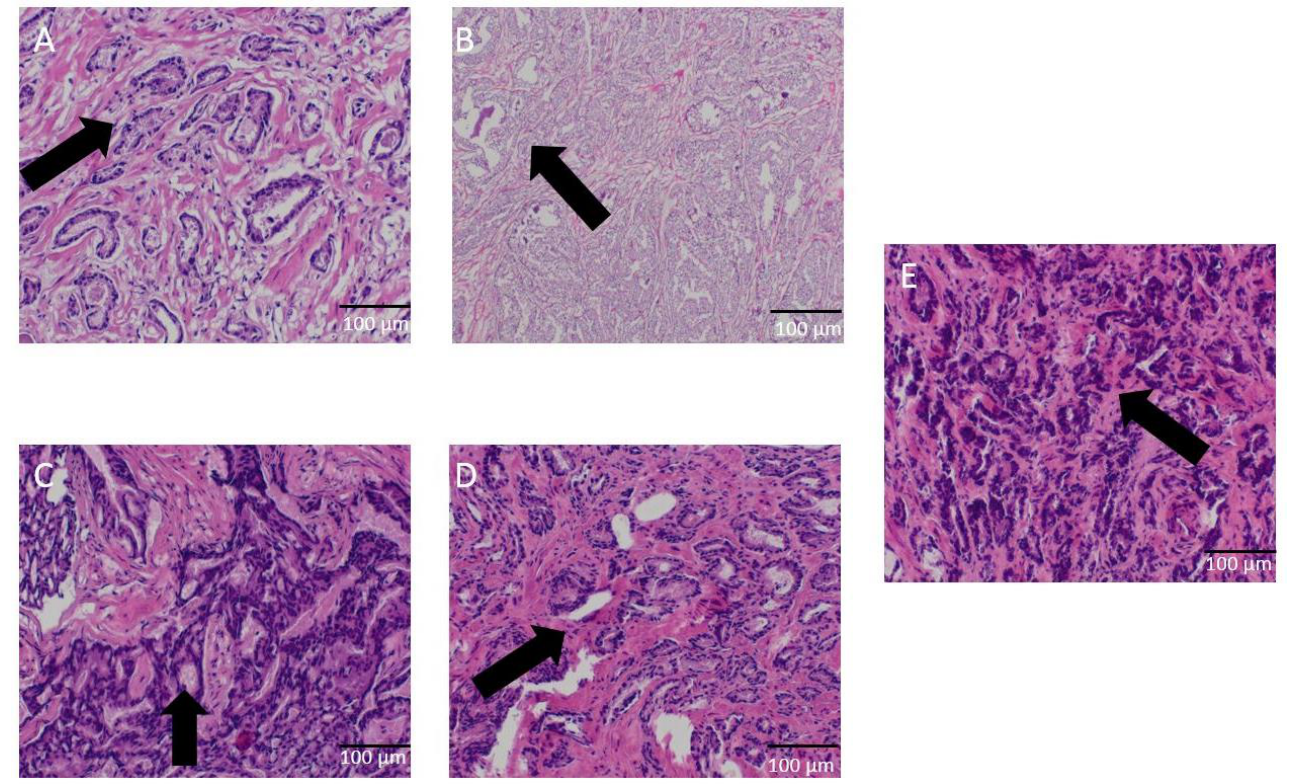
Figure 4. Prostate cancer tissue after PDT with different concentration of RB. Arrows indicate the observed changes presented in the description. Upon application of 0.01 mM RB ( A ), discrete chromatin condensation in most of the cancer cell nuclei and swelling of the stroma are visible. Predominantly normal prostate cancer cells illustrate the irregular arrangement and size of the cells. The architecture of the glands is virtually unchanged, and some cancer cells still have distinct nucleoli. Visible contours of the nuclear membrane. Thrombotic necrosis developed upon application of a concentration of 0.02 mM RB ( B ). In addition to the dense cytoplasmic areas, lighter zones that have a pinkish color after treatment with Rose Bengal were detected. PDT with the application of Rose Bengal at a concentration of 0.03 mM ( C ) showed mild chromatin condensation, irregular shape of the nuclei, and significant architectural disturbances. The cells shown are surrounded by dark cells that stain much more intensely. After the application of 0.04 mM RB ( D ), mild to massive chromatin condensation, pyknotic nuclei, and significant architectural disturbances were observed. These changes were also accompanied by swelling and the presence of protein in the stroma. Fragment of epithelium in a small percentage of cells with the presence of homogeneous chromatin with almost complete loss of chromatin granularity was observed. In the last stage after the application of 0.05 mM RB ( E ), enhanced traits of cell damage and necrosis, which are easily identified. Cell nuclei and whole cells stick together, which makes them indistinguishable. There is also swelling and the presence of protein in the stroma. All microscopic images are at 63× magnification. Histological examination of prostate tumor tissues showed PDT damage to the testicular cells of the tumor cells. Histological images showed visible epithelium of cancer with a picture of cellular pyknosis. In the case of healthy prostate tissues, histological images after PDT differed from those for cancerous tissues. In the case of healthy tissues, areas with damage due to PDT were found much less frequently and in a small area.